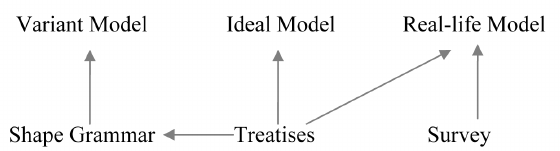
Figure 2. Central role of treatises in producing different